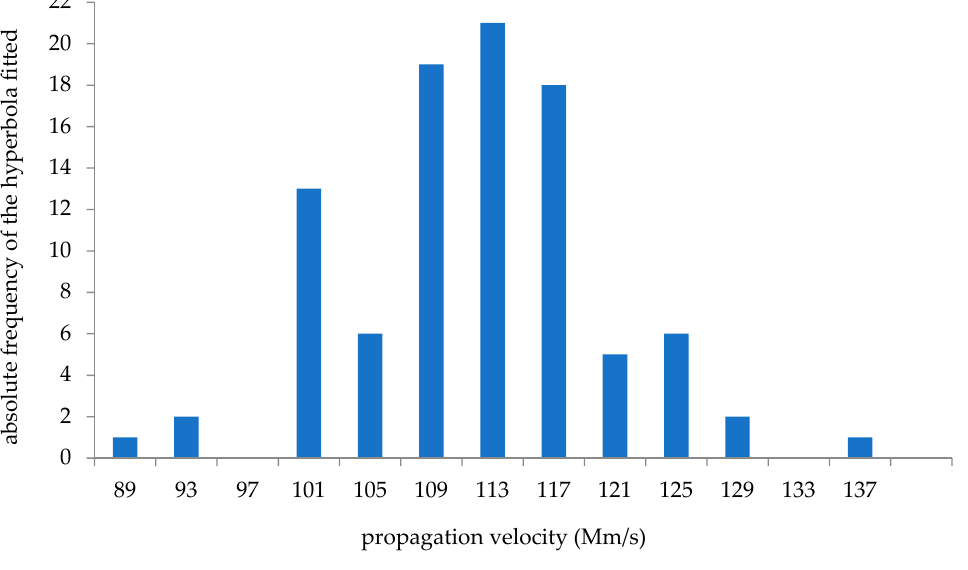
Figure 6. Histogram of the propagation velocities measured through the fitting hyperbola method. The propagation velocities in the X axis of the chart were plotted in a bin of 4.0 Mm/s.